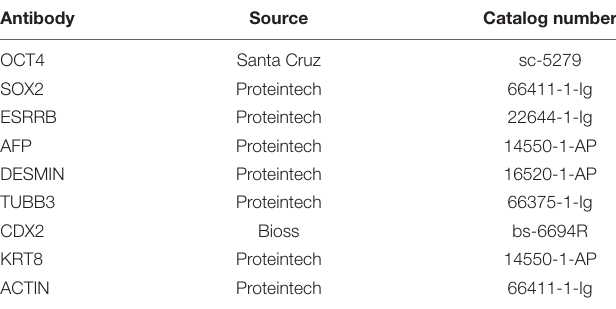
TABLE 4 | Antibodies used in this